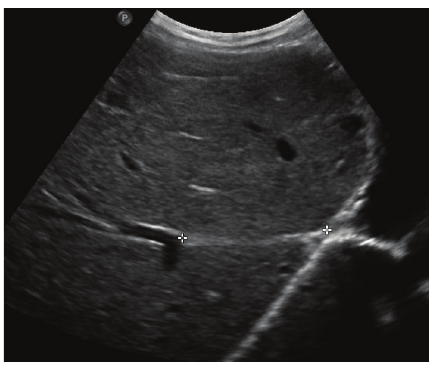
Figure 13: Gray-scale US image showing the distal portion of right hepatic vein (marked by calipers) being reduced to a cord-like structure due to chronic thrombosis.